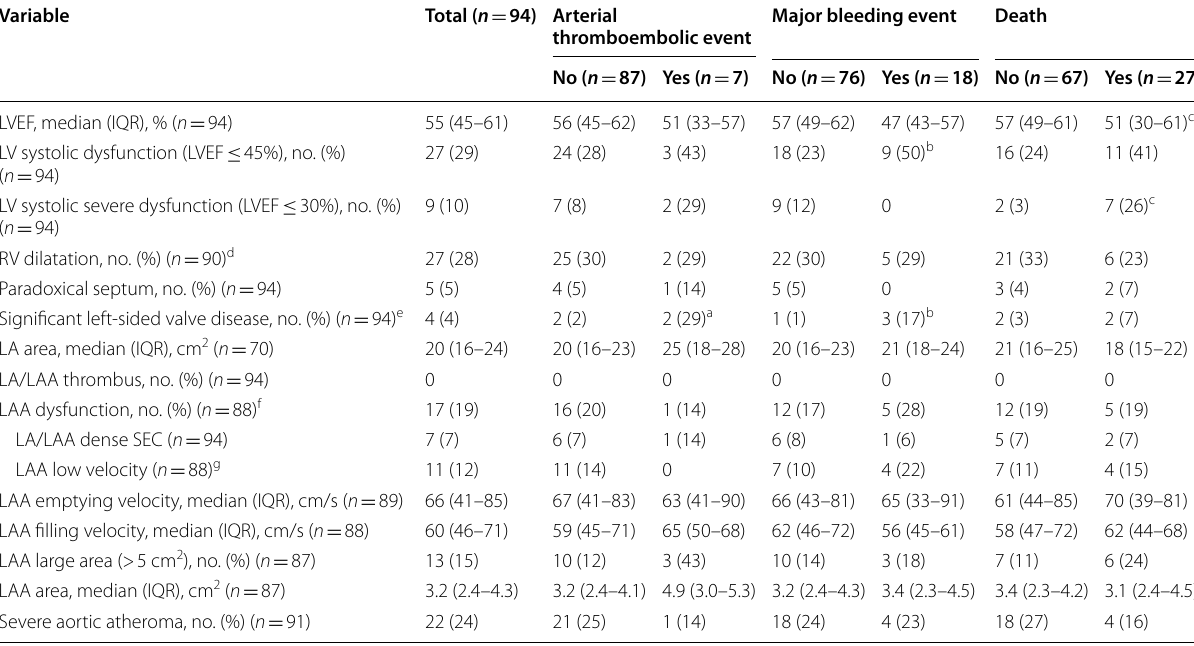
Table 2 Initial transthoracic and transesophageal echocardiographic variables according to 28‑day arterial thromboembolic events, major bleeding events, and